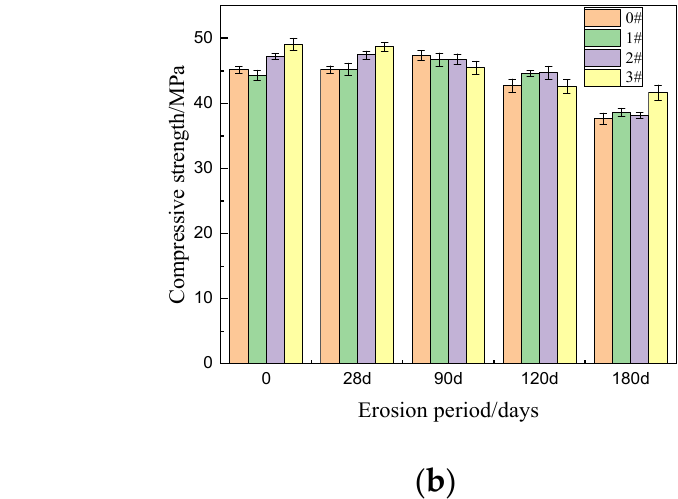
Figure 5. Compressive strength of PC and M10 after a different erosion period under various curing